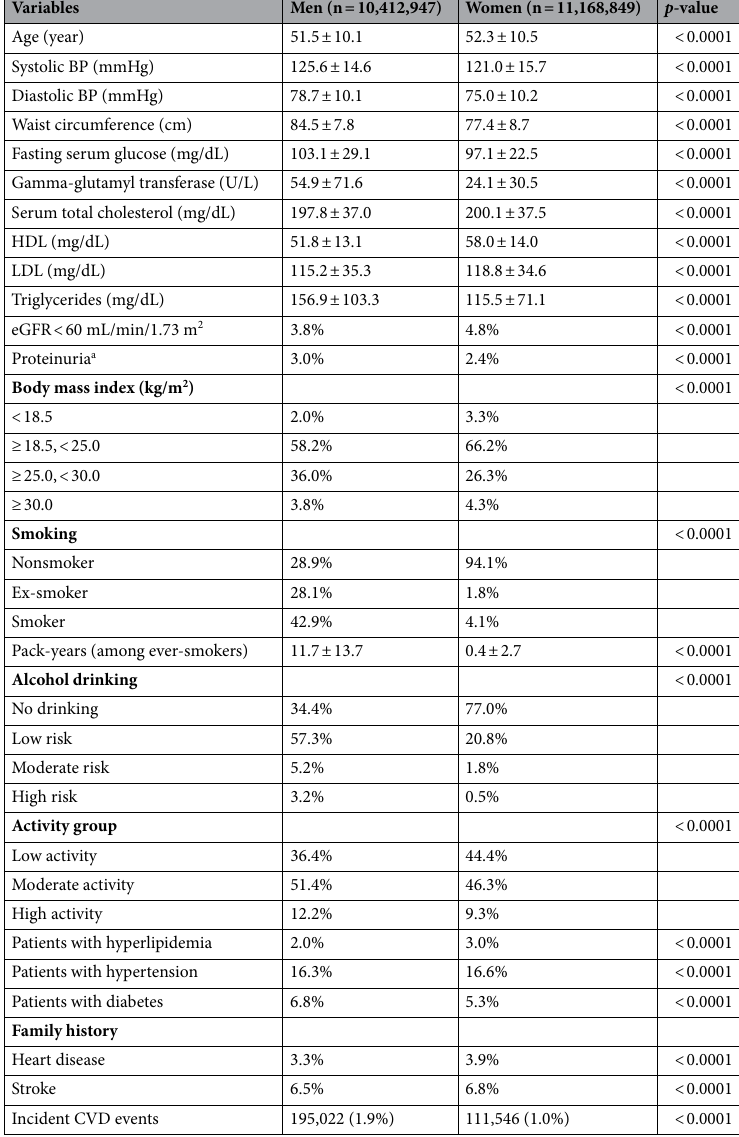
Table 1. Baseline characteristics of the subjects by sex. Percentages for categorical variables; the mean ± standard deviation for continuous variables. The p -value was calculated by t-test for continuous variables and Pearson’s chi-squared test for categorical variables. BP blood pressure, HDL high-density lipoprotein cholesterol, LDL low-density lipoprotein cholesterol, eGFR estimated glomerular filtration rate, CVD cardiovascular disease. a ≥ 1 + in urine dipstick for